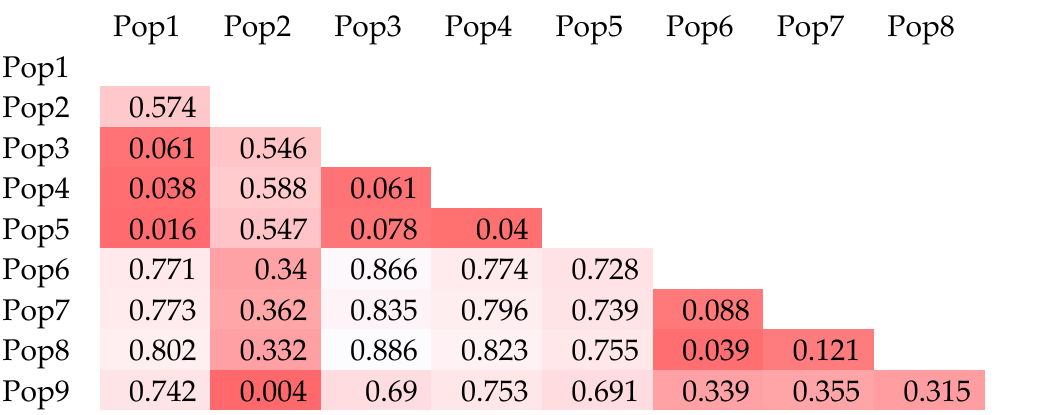
Figure 3. Heatmap of pairwise F ST values estimated from microsatellite data between all populations. All values are significant at the P < 0.001 level, a dark color indicates the minimum value of genetic variation, and a light color indicates the maximum value of genetic variation between populations. For abbreviations of localities see Table 1.